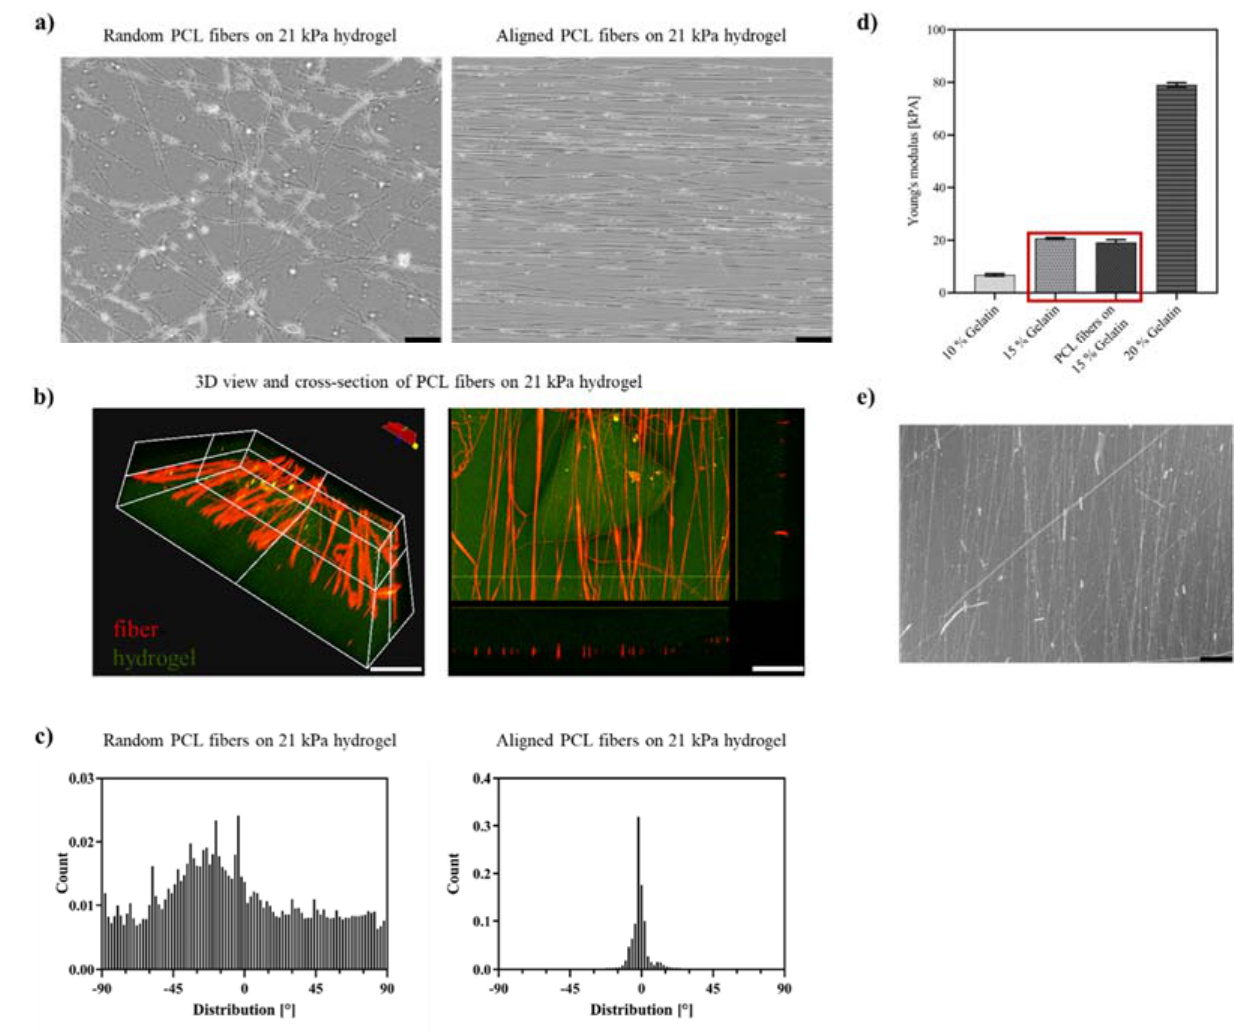
Figure 3. Scaffolds of electrospun PCL fibers on gelatin hydrogels. ( a ) Optical micrographs of random and aligned electrospun PCL fibers on 21 kPa hydrogels, scale bar = 100; ( b ) 3D volume view and cross section of confocal micrographs of PCL fibers (in red) on 21 kPa hydrogels (in green), scale bar = 200 µ m; ( c ) Histograms with distribution of directionality µ m of PCL fibers on 21 kPA hydrogels (left: random with number of fibers N = 200, right: aligned with number of fibers N = 500); ( d ) Elastic modulus [kPA] of transglutaminase-crosslinked gelatin hydrogels, highlighted with red box 15% gelatin with and without PCL fibers at 37 ◦ C, number of hydrogels N = 9; ( e ) PCL fibers on 21 kPa gelatin hydrogel after 28 days at 37 ◦ C/5% CO 2 in cell culture medium, scale bar 100 µ m.